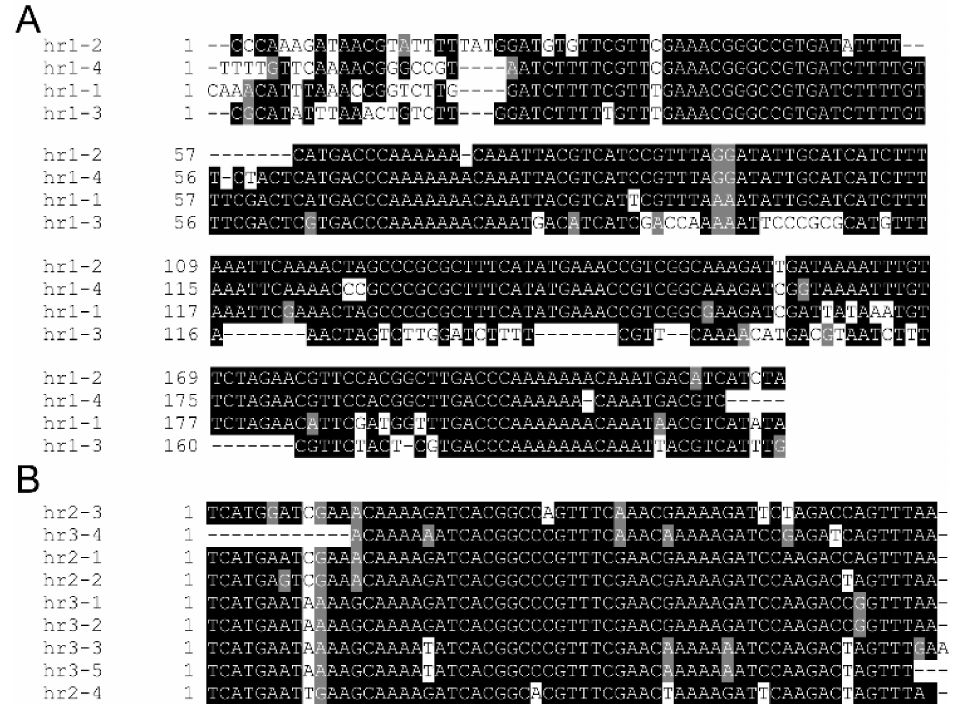
Figure 3. Alignment of hrs of HearNPV-BJ: Shading is used to indicate the relevant occurrence of similar nucleotides in the repeats. ( A ), alignment of hr1 . ( B ), aligment of hr2